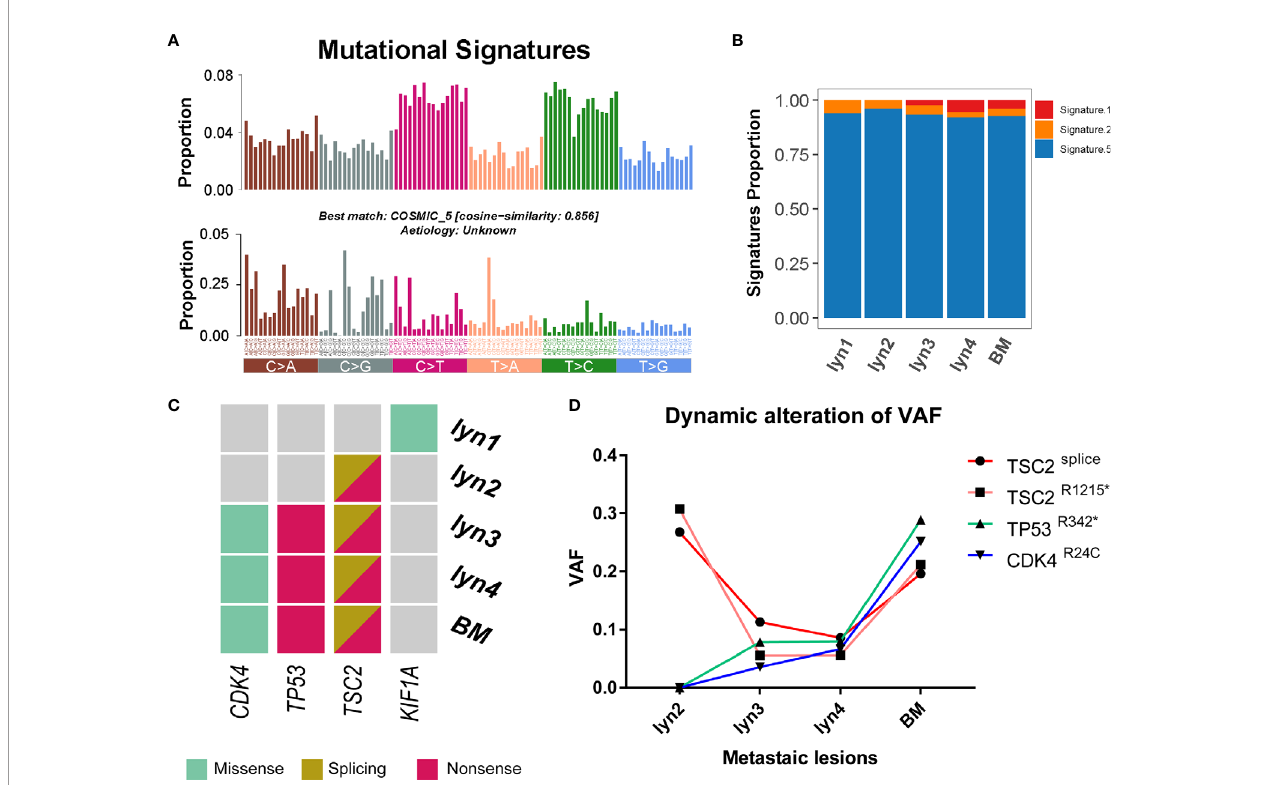
FIGURE 2 | Landscape of mutation signature and potential driver mutations. (A) The 96-mutatinal classes of all somatic point mutations and the best matched signature; (B) Estimated signature component and relative ratio in each sample; (C) Heatmap of potential driver mutations in each sample; (D) Dynamic changes of variant allele frequencies of mutations in TSC2 , TP53 and CDK4 along with the time course.